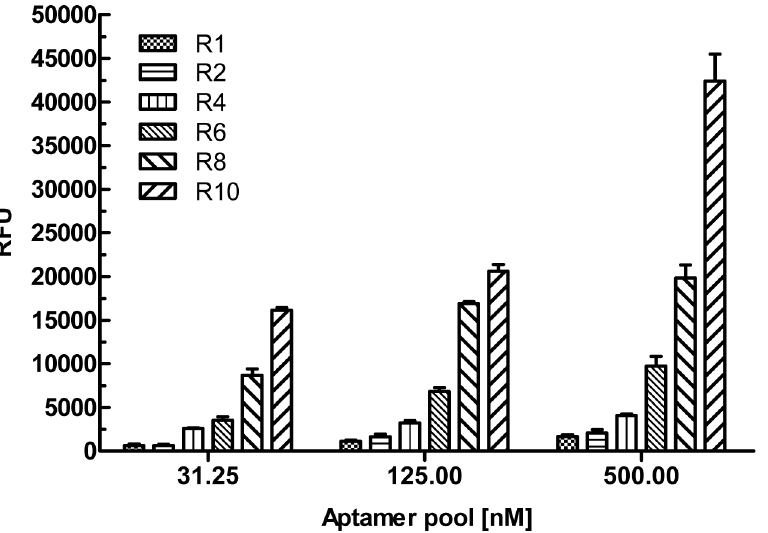
Figure 1. Binding analysis of aptamer pools at various rounds of TESA SELEx. Biotinylated aptamer pools obtained at rounds 1, 2, 4, 6, 8 and 10 of the TESA SELEx were used at various concentrations (31.25, 125 and 500 nM) in an ELA assay to demonstrate binding to TESA coated on a polystyrene 96 well plate. Signal generated, relative fluorescence units (RFU), are plotted on the Y-axis and each bar represents the mean of duplicate values with standard deviation. Data shows a gradual enrichment and evolution of TESA binding aptamers from the starting SELEx library to round 10.